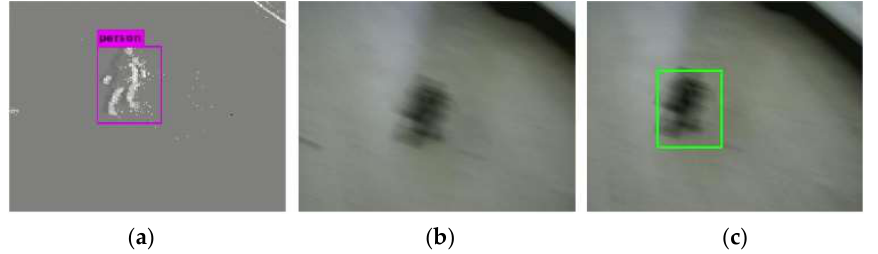
Figure 12. Results of combined detection (event frame: detected, standard frame: missed). ( a ) Event frame-based detection, ( b ) Standard frame-based detection, ( c ) Combined detection.